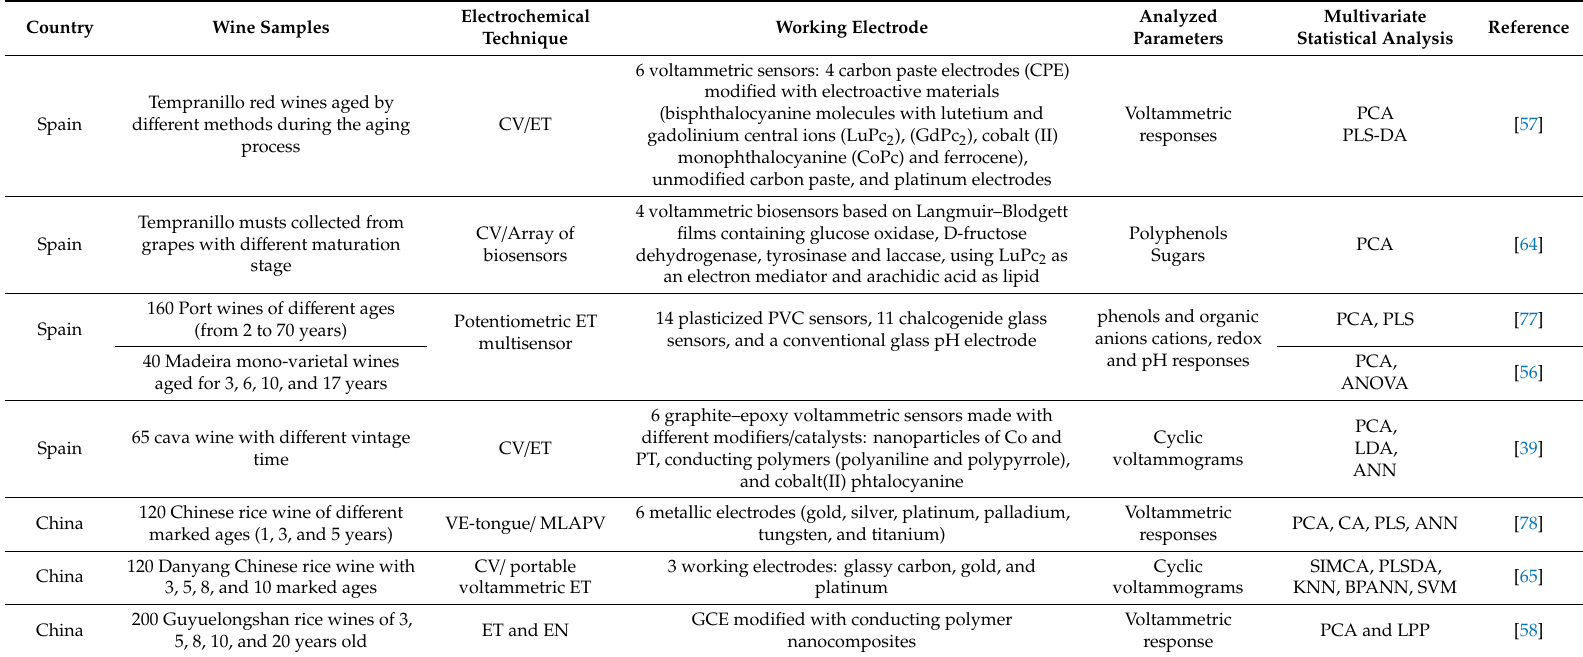
Table 2. Monitoring of wine aging and vintage year